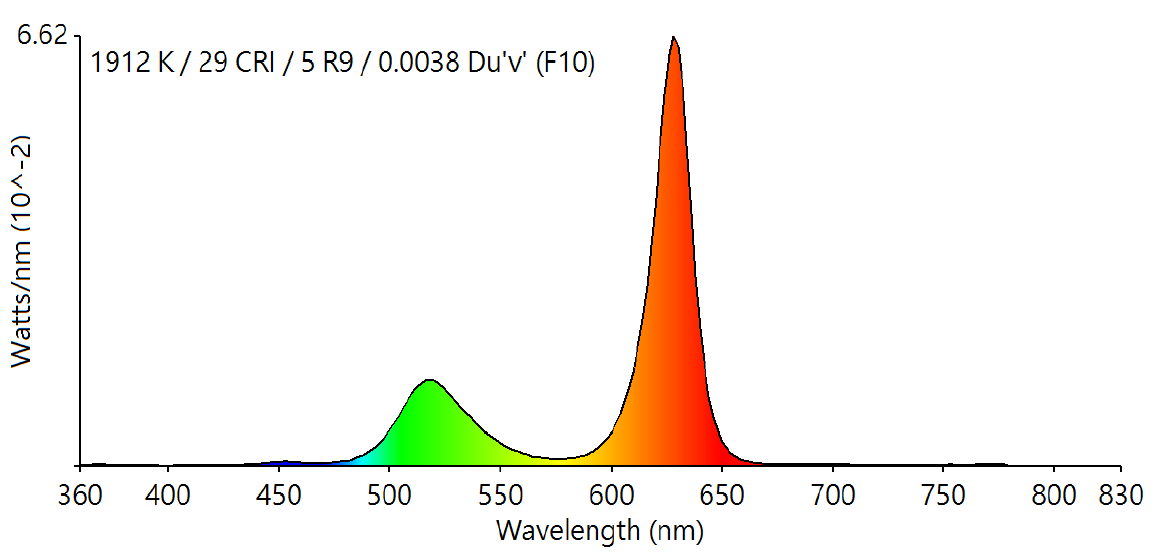
Figure 4. Dim light spectrum, which is the same as the lowest Dynamic CCT lighting spectrum (1900 K), is designed according to the night light spectrum.